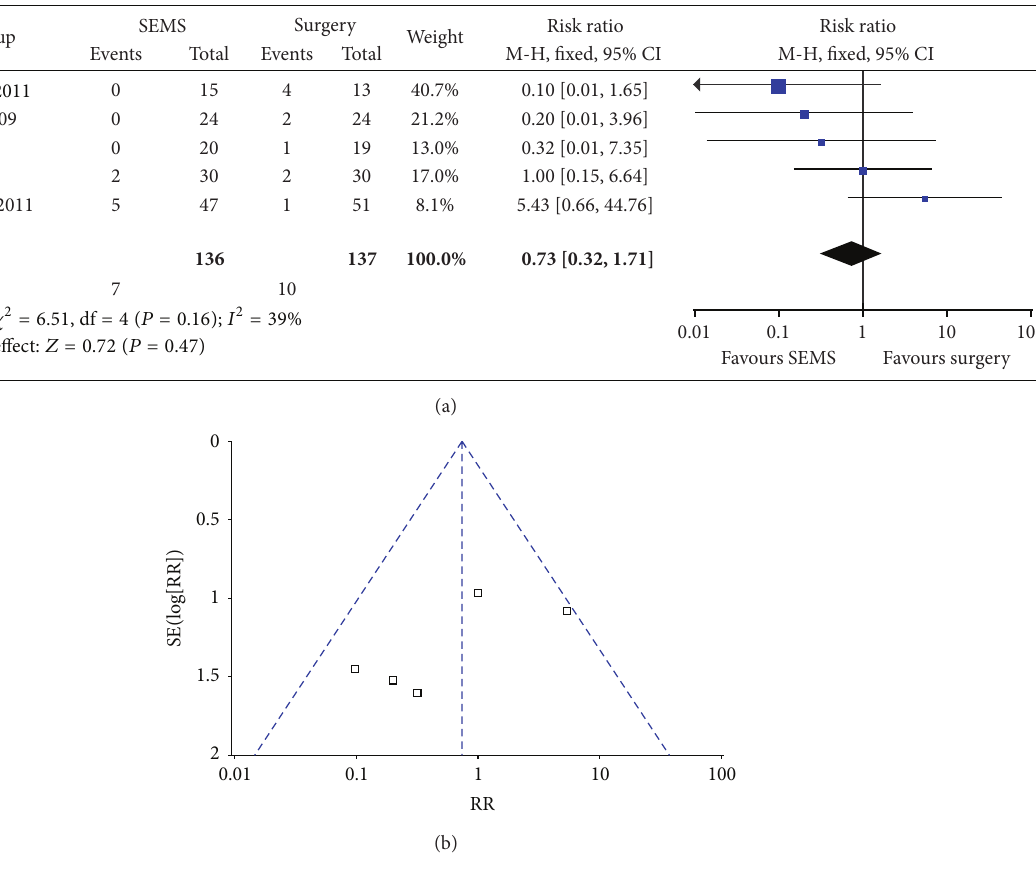
Figure 4: Forest plot and funnel plot of the rate of anastomotic